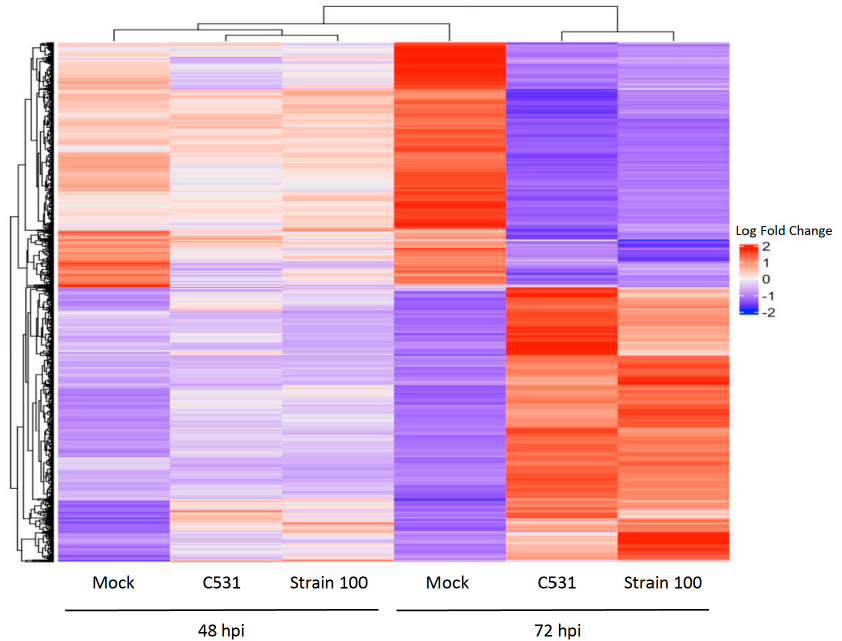
Figure 5. Hierarchical clustering analysis of gene expression patterns in BAT93. Heat map showing the expression levels of significant DEGs in inoculated plants vs. Mock. Up-regulated and down- regulated genes are represented in red and blue, respectively.